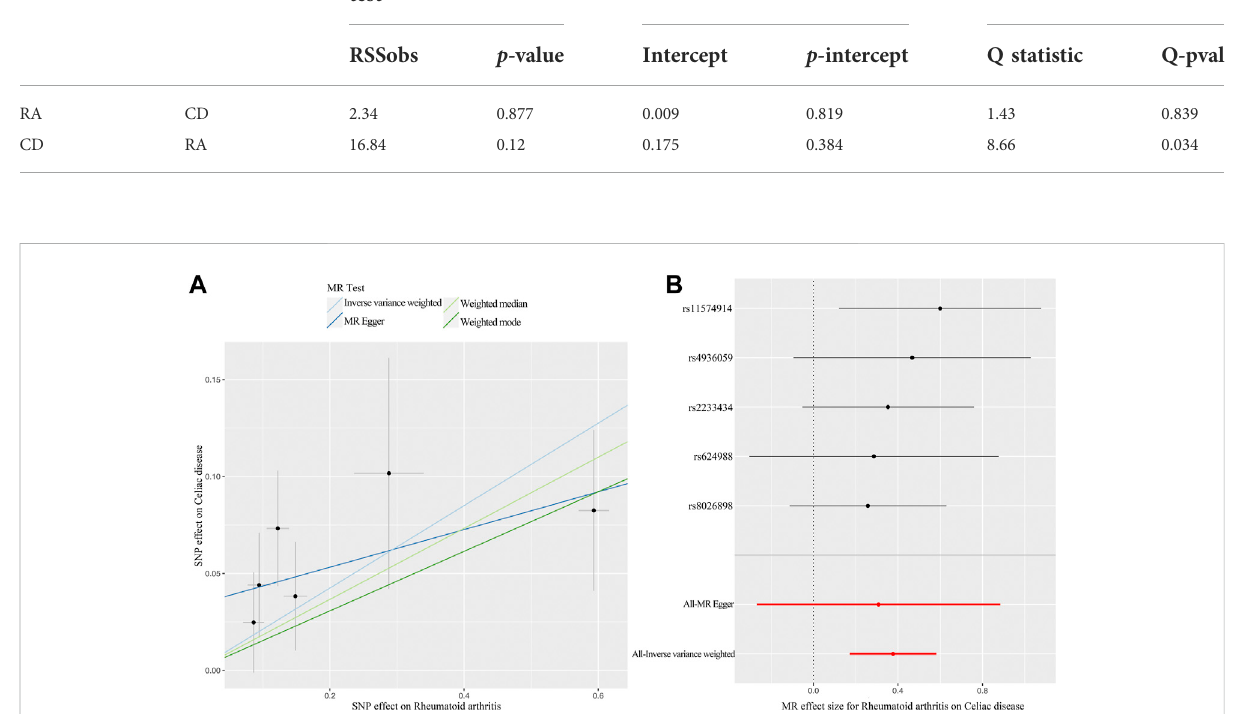
FIGURE 3 MRplotsforthecausaleffectofRAonCD. (A) ScatterplotforthecausalrelationshipofRAonCD. (B) ForestplotforthecausalrelationshipofRA on CD. Abbreviation: MR, Mendelian randomization; RA, rheumatoid arthritis; CD, celiac disease; SNP, single nucleotide